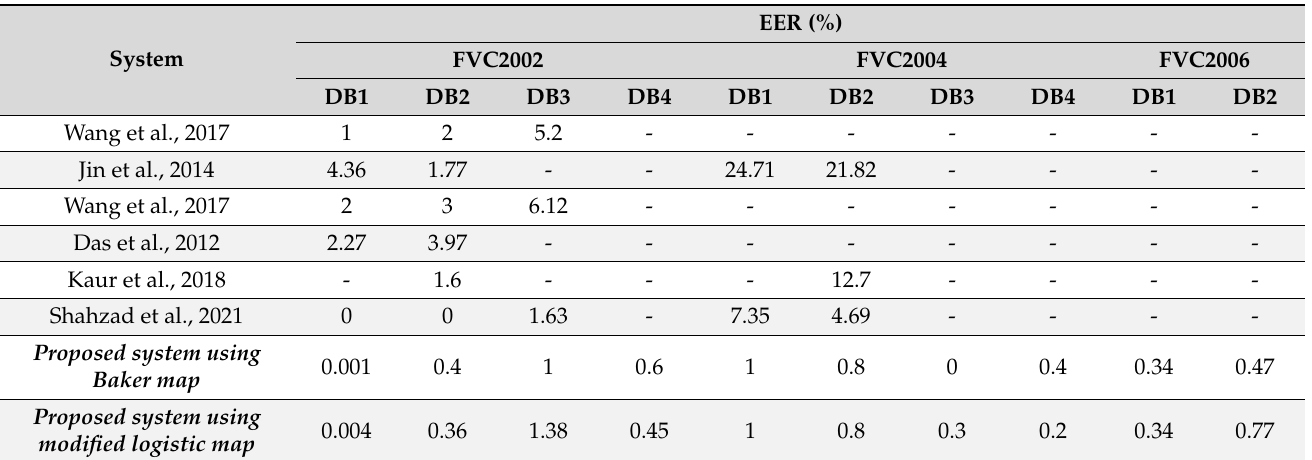
Table 7. The EER comparison for various cancelable biometric recognition systems.